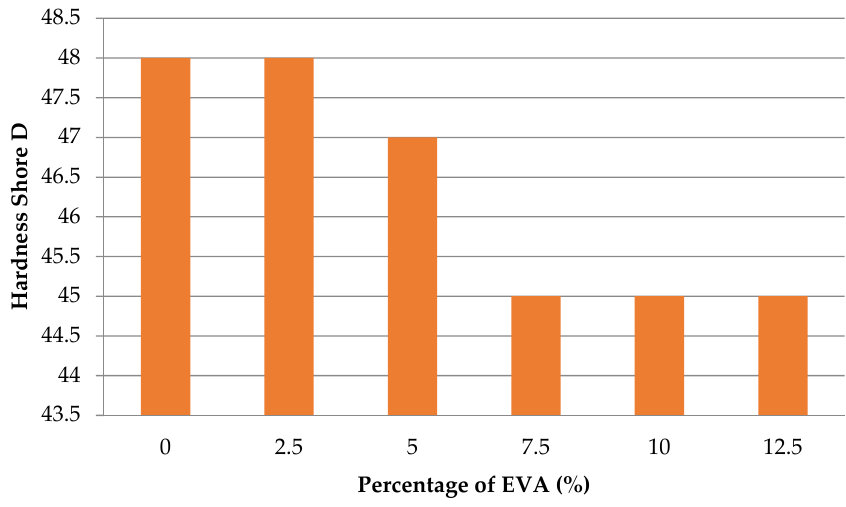
Figure 4. Hardness average values of test samples.